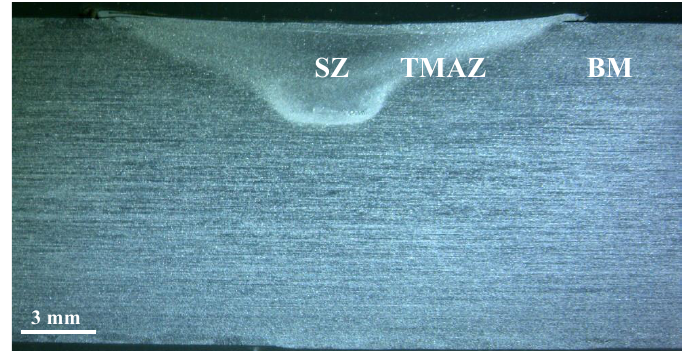
Figure 2. Low-magnification overview of the transversal cross-section of the AA6082 plate subjected to FSP.